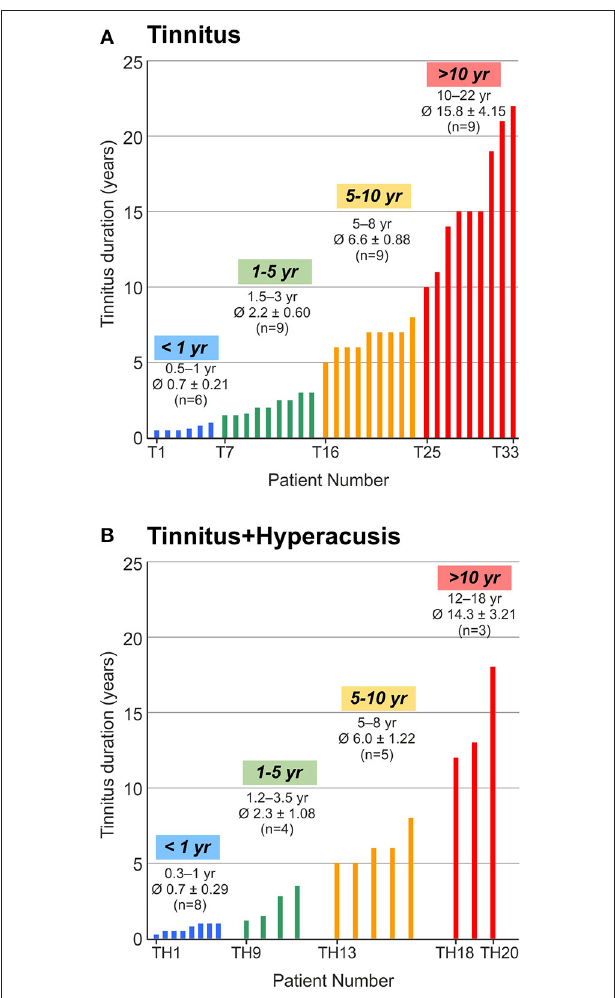
FIGURE 1 | Distribution of participants according to the time of persistence of their tinnitus (tinnitus duration in years, yr). (A) 33 participants with tinnitus (T1 to T33) were classified into 4 groups of tinnitus duration up to 1 year ( < 1 yr), more than 1 year up to 4.9 years (1–5 yr), from 5 years up to 9.9 years (5–10 yr) and from 10 years and more ( > 10 yr). (B) 20 participants with tinnitus and hyperacusis (TH1 to TH20) were classified accordingly. Groups were color coded by blue, green, yellow, and red in respect to tinnitus duration throughout this manuscript. Calculation with Kruskal-Wallis test showed no difference between tinnitus and tinnitus + hyperacusis within the tinnitus duration